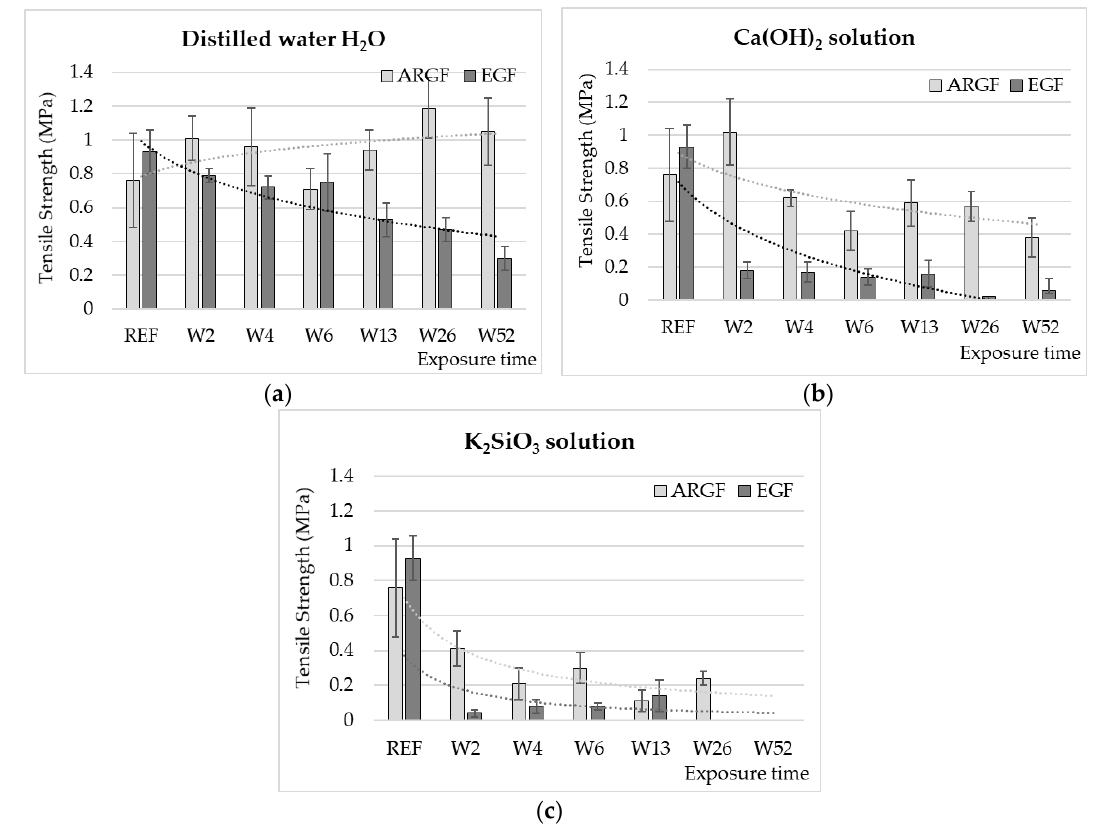
Figure 1. Strengths of ARGFs and EGFs (average value of 10 measurements at minimum, excluding outliers) after treatment in a neutral environment: ( a ) H 2 O and alkaline environments, ( b ) Ca(OH) 2 , and ( c ) K 2 SiO 3 solutions depending on exposure time (x-axis, in weeks). The dotted lines in the graphs indicate the trend lines.